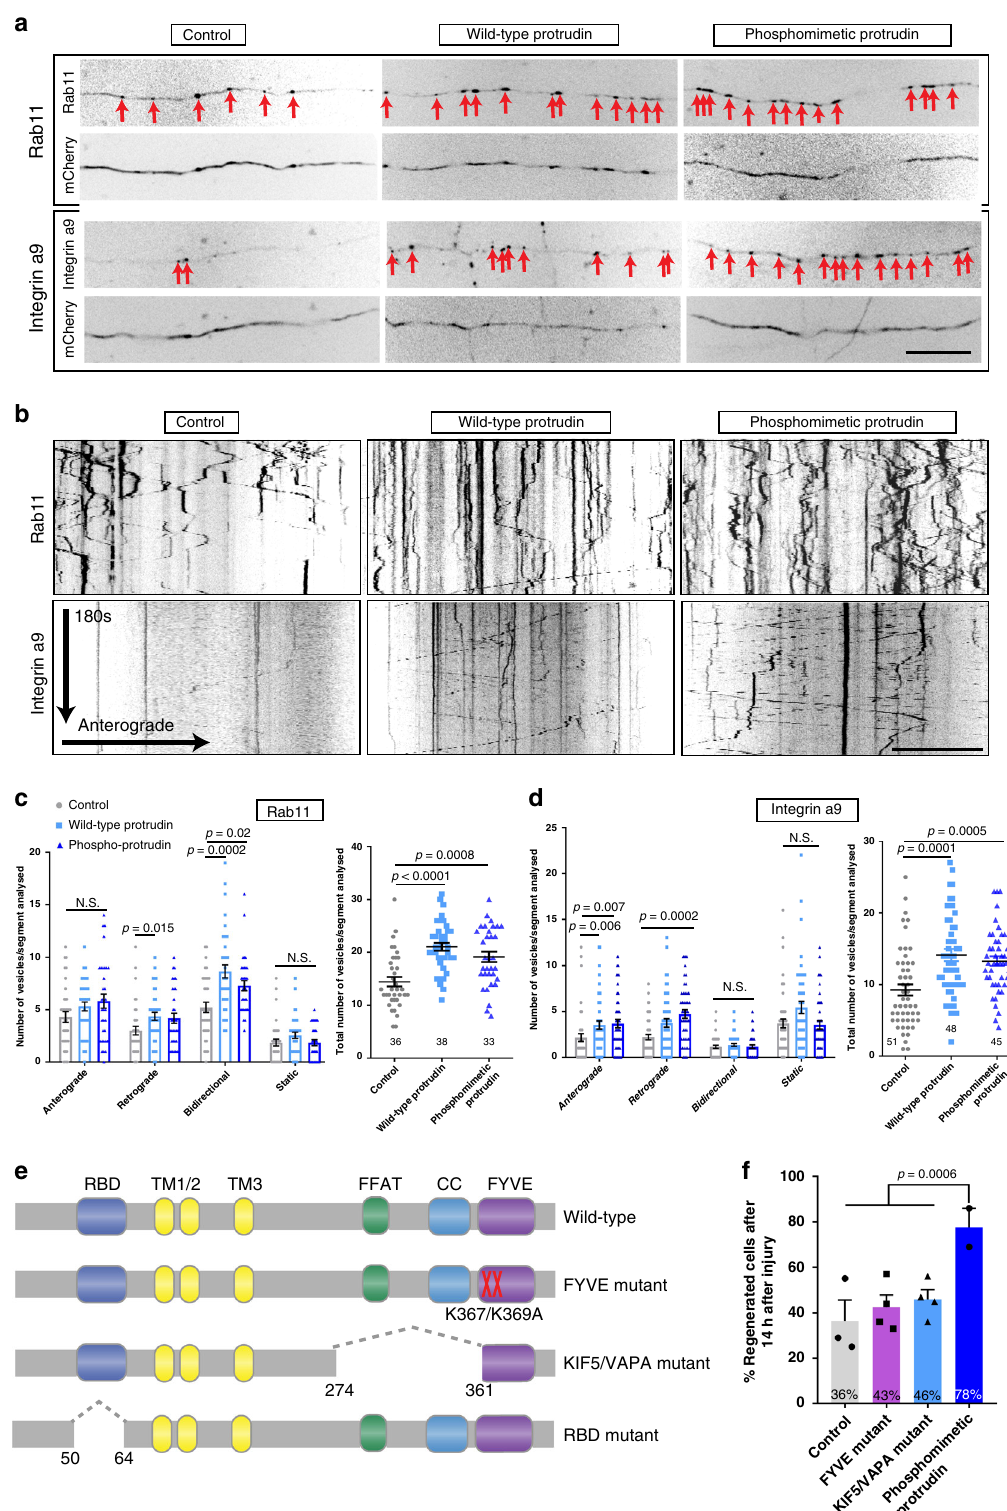
signi fi cantly higher percentage of surviving RGCs (52%) com- pared to those injected with GFP control (28%) whilst trans- duction with wild-type Protrudin (27%) had no effect (Fig. 5c, d). In contrast, both wild-type and phosphomimetic Protrudin had robust effects on axon regeneration. Optic nerves of mice expressing GFP exhibited limited regeneration (0% >0.5 mm